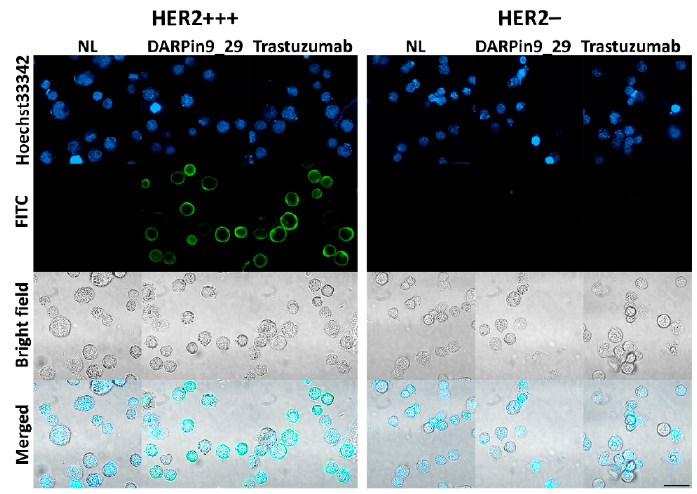
Figure 8. Confocal laser scanning microscopy of SK-BR-3 and CHO cells, labeled with DARPin9_29- FITC and Trastuzumab-FITC. Bottom panels—bright-field images, top panels—fluorescent images of the cells labeled with FITC-conjugated proteins, and Hoeschst33342. Scale bar, 50 μ m.